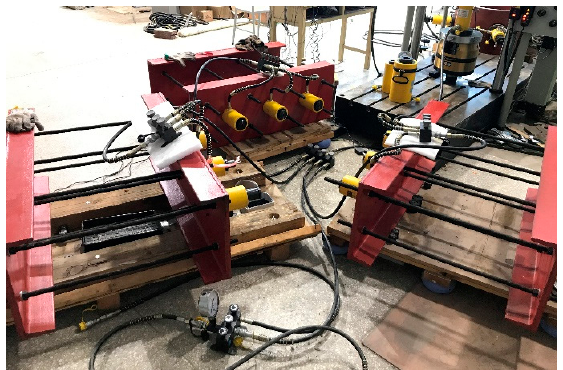
Figure 5. Diagram of synchronous pulsation fatigue loading device.